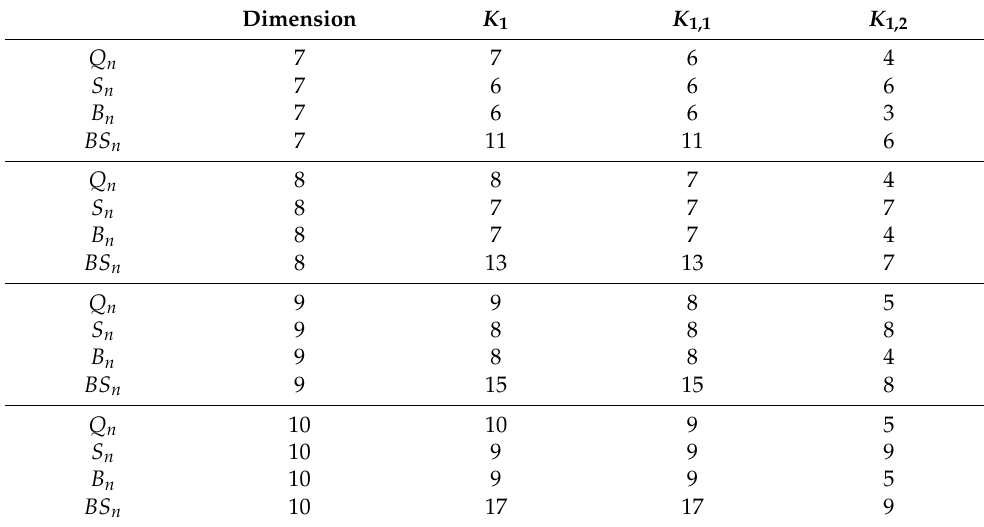
Table 2. Comparison of { K 1 , K 1,1 , K 1,2 } -(sub)structure connectivity. Dimension K 1 K 1,1 K 1,2 Q